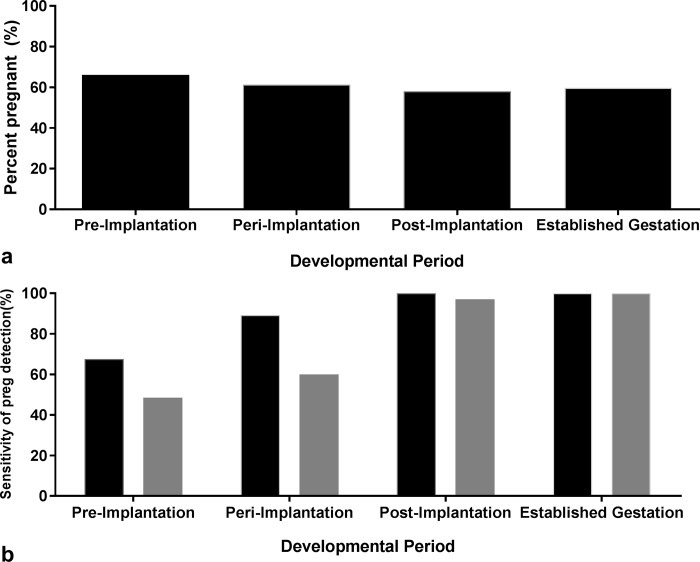
The a) percentage of ewes detected as pregnant by TRUS and TCUS (established gestation only and b) sensitivity of TRUS (TP% = #TP/#TP+#FP; [35]) to correctly detect pregnancy (black bars) and number of conceptuses per ewe (grey bars) during pre-implantation (day 12/14), peri-implantation (day 17/19), post implantation (day 29) and established gestation (day 54).